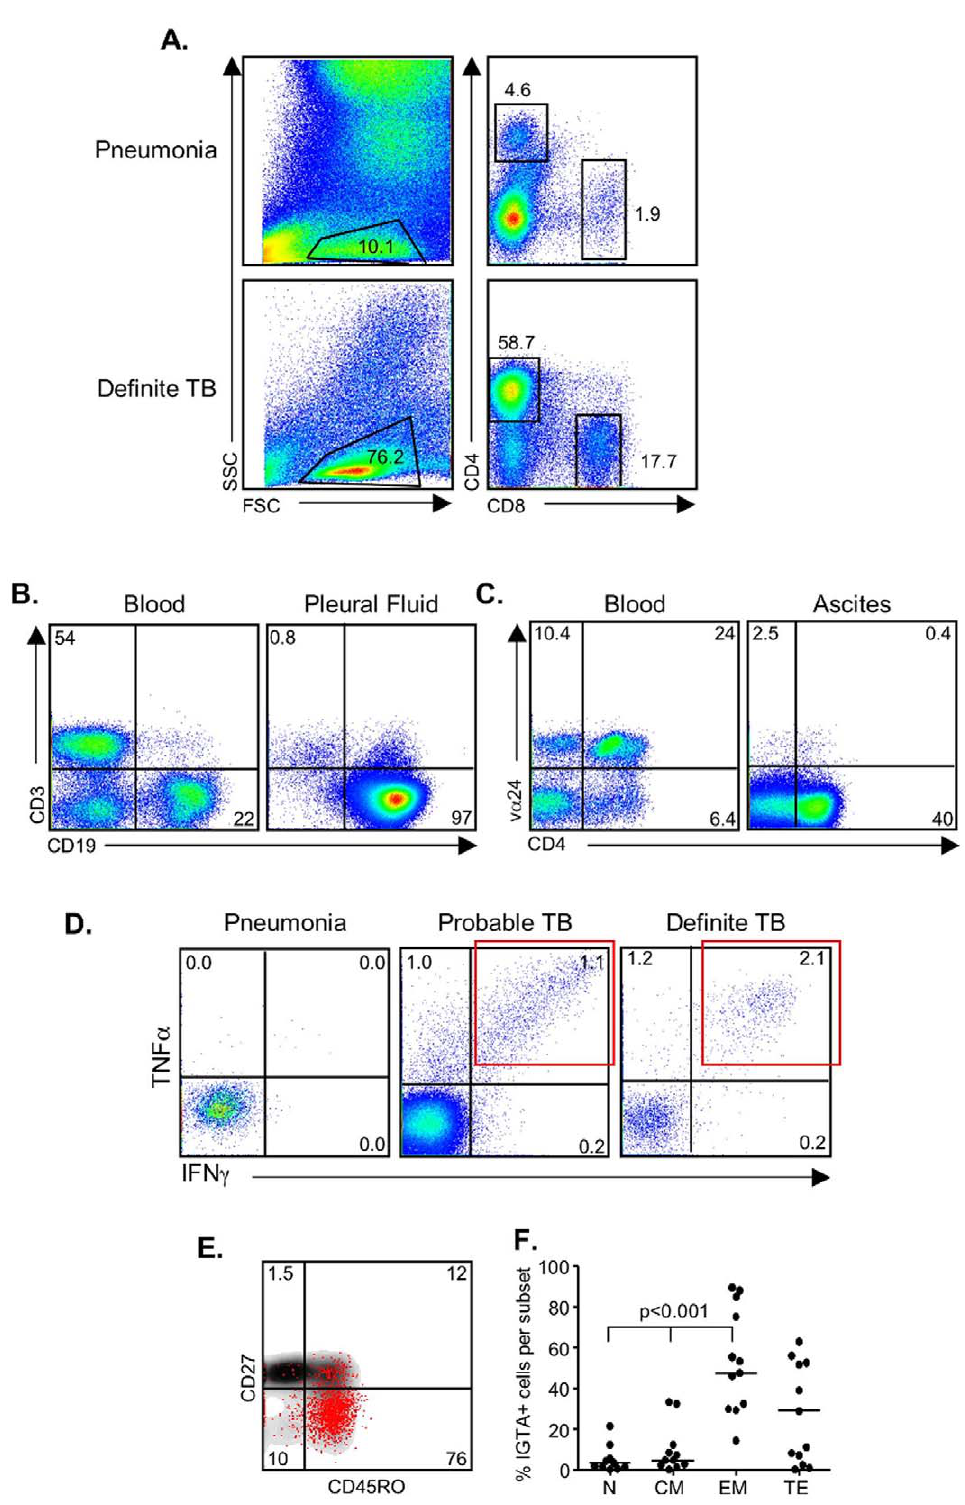
Figure 1. Flow cytometry comparison between peripheral blood and pleural fluid. ( a ) Ex vivo assessment of the cell phenotypes within the pleural fluid. Shown are representative flow cytometry profiles from a patient with pneumonia and one who was diagnosed with TB. Profiles are first gated on the lymphocyte population as determined by FSC and SSC. Following singlet and CD3 gating, analysis of CD4 + and CD8 + T cell populations is performed. ( b ) Analysis of a subject with pleural effusion caused by malignancy. In this case CD3 and CD19 are plotted together to illustrate T and B cell proportions in the blood (left) and pleural fluid (right) of a subject with a malignancy (subject 33). ( c ) Flow cytometry profile from blood and ascites where the blood had a distinct V a 24 + CD4 + T cell population; absent from the ascites. ( d ) Functional analysis of PF cells. Overnight stimulation of PF cells with PPD was followed by intracellular cytokine detection. Following gating on the CD4 + T cells, TNF- a and IFN- c positive cells were